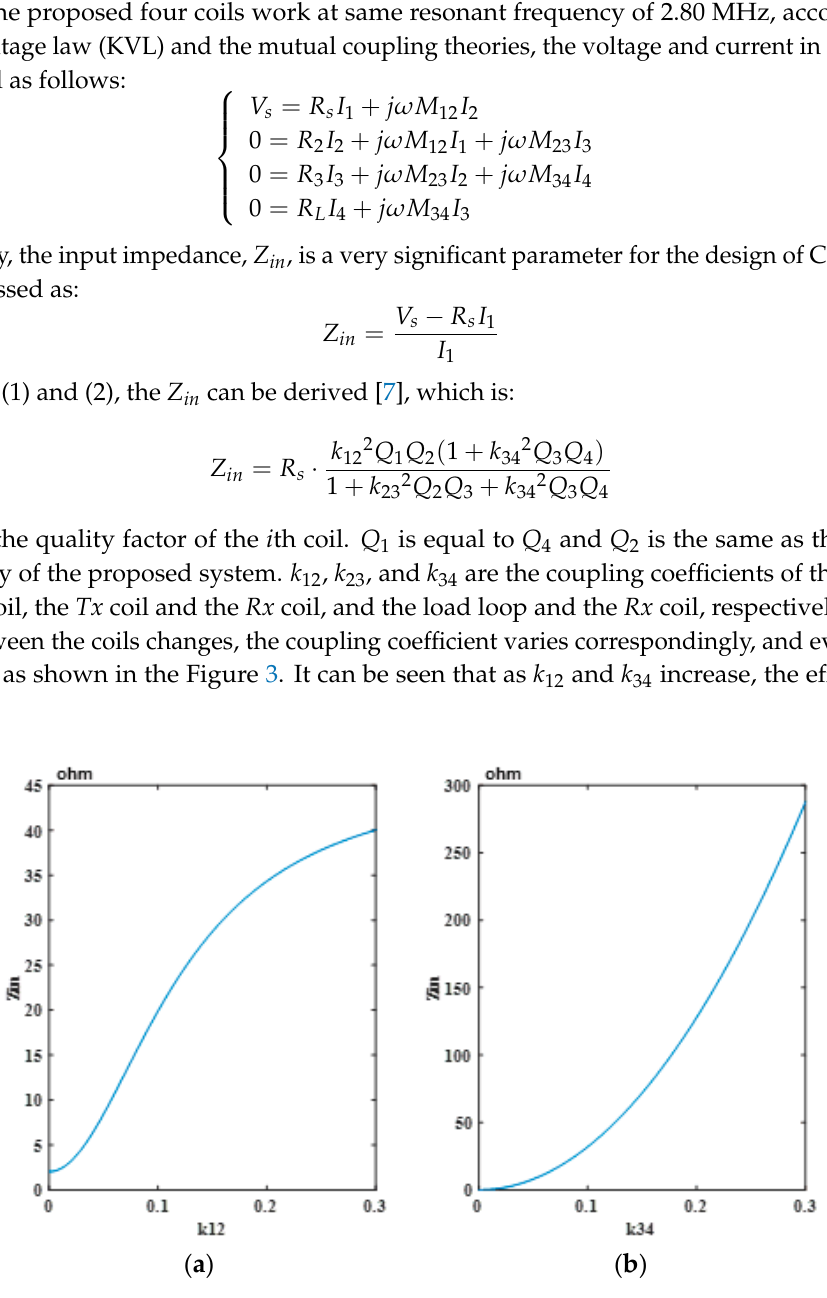
Figure 3. The relationship ( a ) between input impedance Zin and k 12 , and ( b ) between input impedance Zin and k 34 .